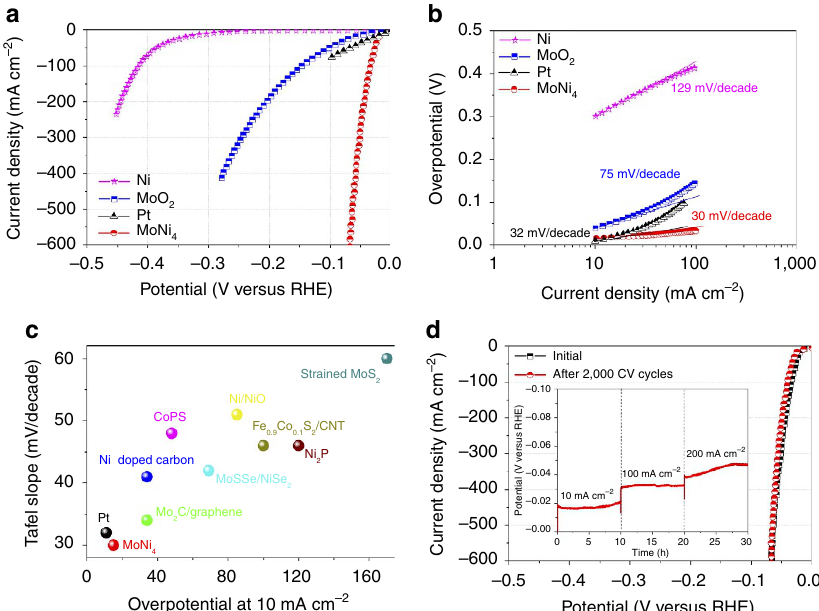
Figure 3 | Electrocatalytic activities of different catalysts. ( a ) Polarization curves and ( b ) Tafel plots of the MoNi 4 electrocatalyst supported by the MoO 2 cuboids, pure Ni nanosheets and MoO 2 cuboids on the nickel foam. ( c ) Comparison with selected state-of-the-art HER electrocatalysts. ( d ) Polarization curves of the MoNi 4 electrocatalyst before and after 2,000 cyclic voltammetry cycles; inset: long-term stability tests of the MoNi 4 electrocatalyst at different current densities: 10; 100; and 200mAcm (cid:2) 2 . Electrolyte: 1M KOH aqueous solution; scan rate: 1mVs (cid:2) 1